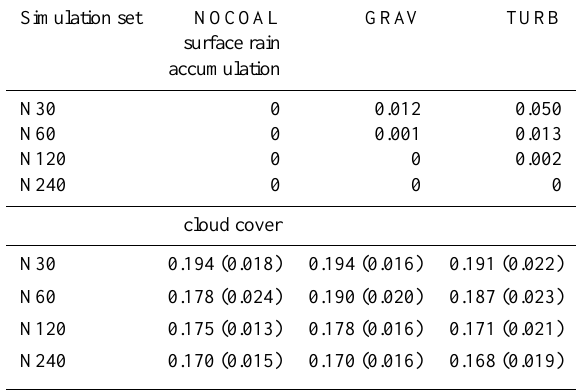
Table 1. Domain-averaged 6h surface rain accumulation (in mm) and mean cloud cover from the last 3h for all simulations discussed in this paper. Cloud cover is defined as a fraction of model columns featuring at least one grid volume with the cloud water mixing ratio larger than 0.01gkg − 1 . The numbers in brackets for the cloud cover are standard deviations of the 3h time